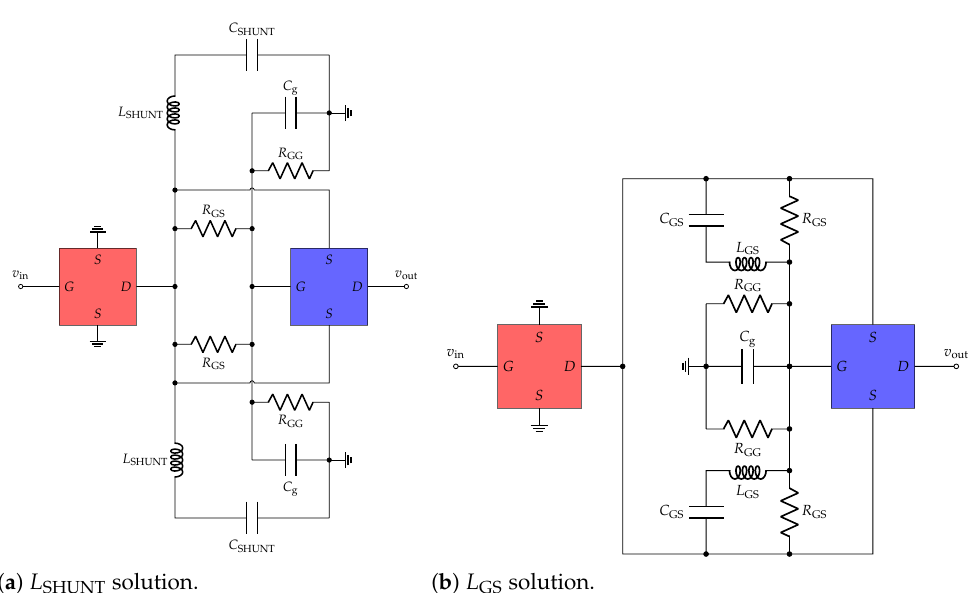
Figure 15. Layout-like schematics of the cells (transmission lines not shown). As illustrated in Figure 16b, when distributed elements are used, not only their phase delay impacts on the loads seen by the devices, but also the choice of the connection point for the matching elements. Figure 16 concerns the L GS solution, but very similar considerations apply for the L SHUNT one.